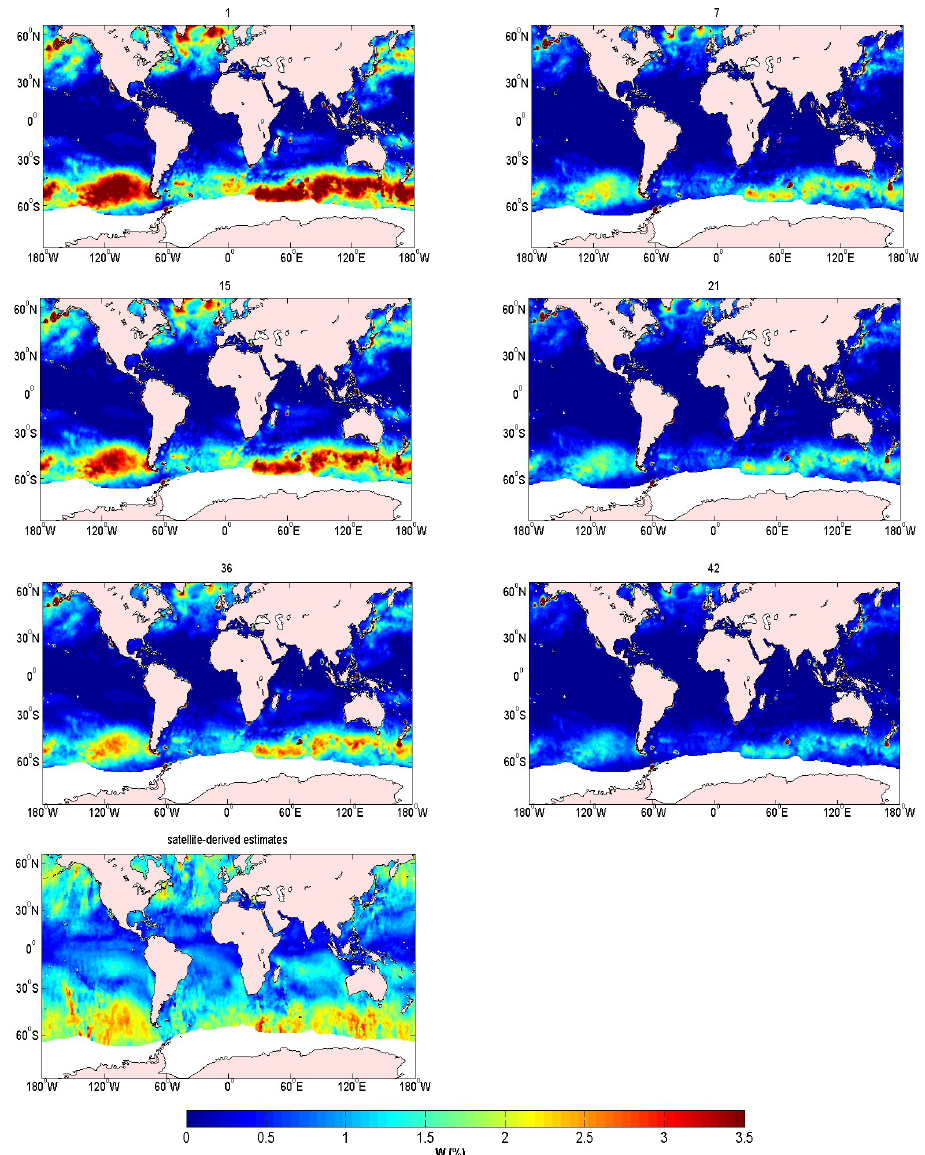
Figure 2. Global whitecap coverage in October 2006 for combination numbers 1, 7, 15, 21, 36, and 42 (See Table 2 for more details about the different combinations) and the satellite-derived estimates of the global whitecap coverage in October 2006. A unified scale colorbar with values from 0 to 3.5% is used.